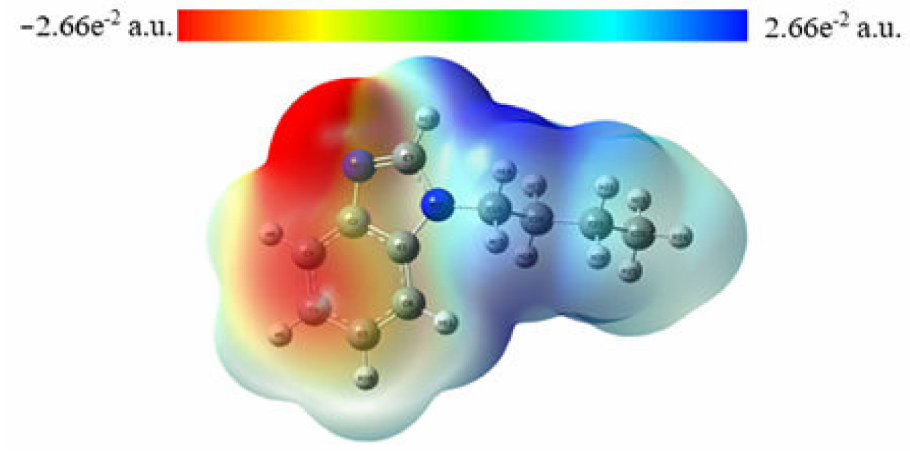
Figure 6. Molecular electrostatic potential